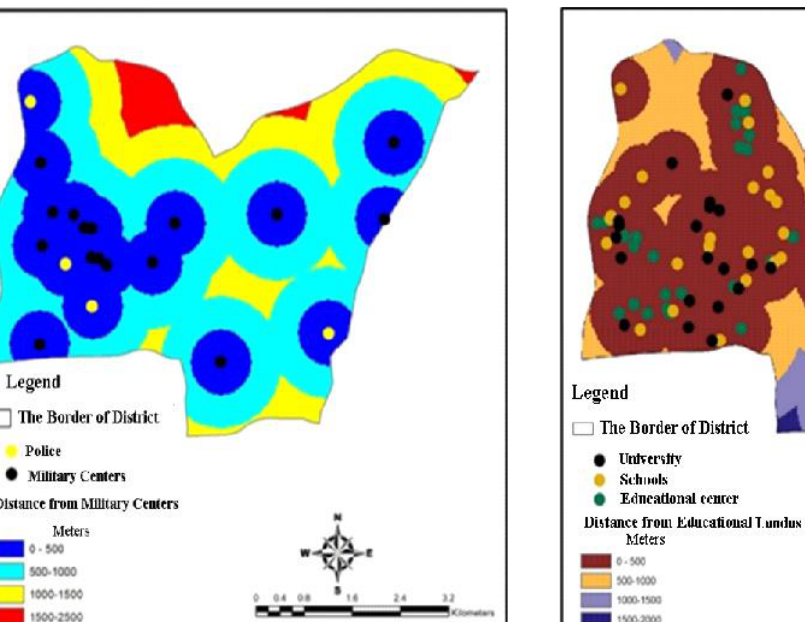
Fig. 12: The distance from Educational centers